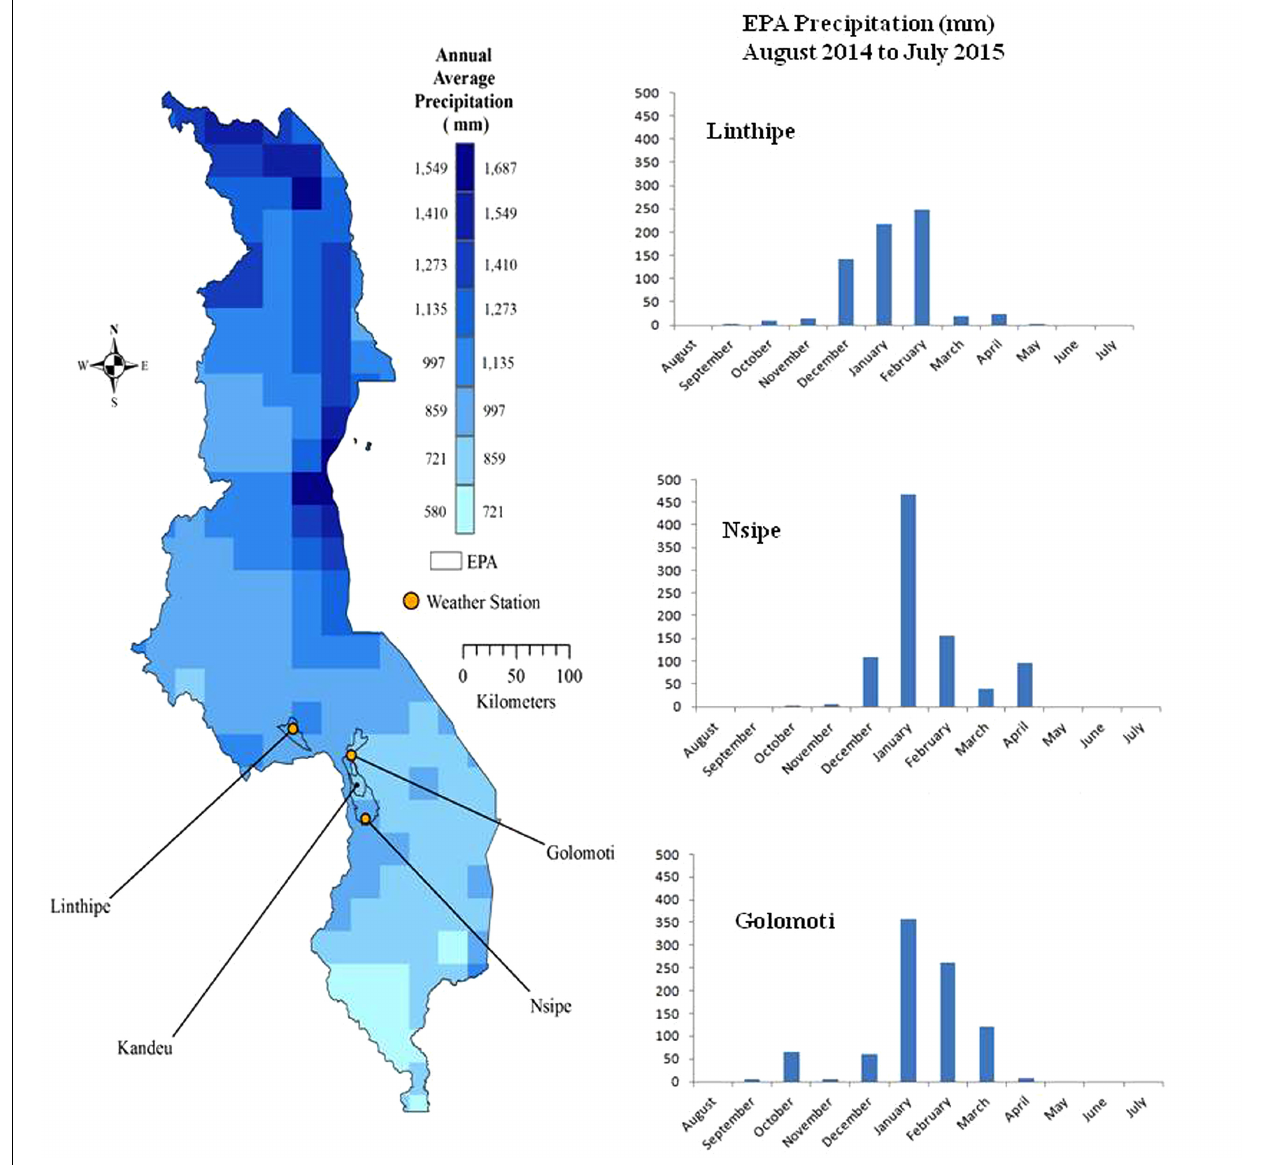
FIGURE 1 | Malawi Annual Average Precipitation (mm) based on Tropical Rainfall Measuring Mission (TRMM) rainfall data for 2001–2015; and monthly rainfall amounts of selected Extension Planning Areas (EPAs) from Weather Station datasets for August 2014 to July 2015 (Linthipe 667 mm, Golomoti 884 mm, and Nsipe 875